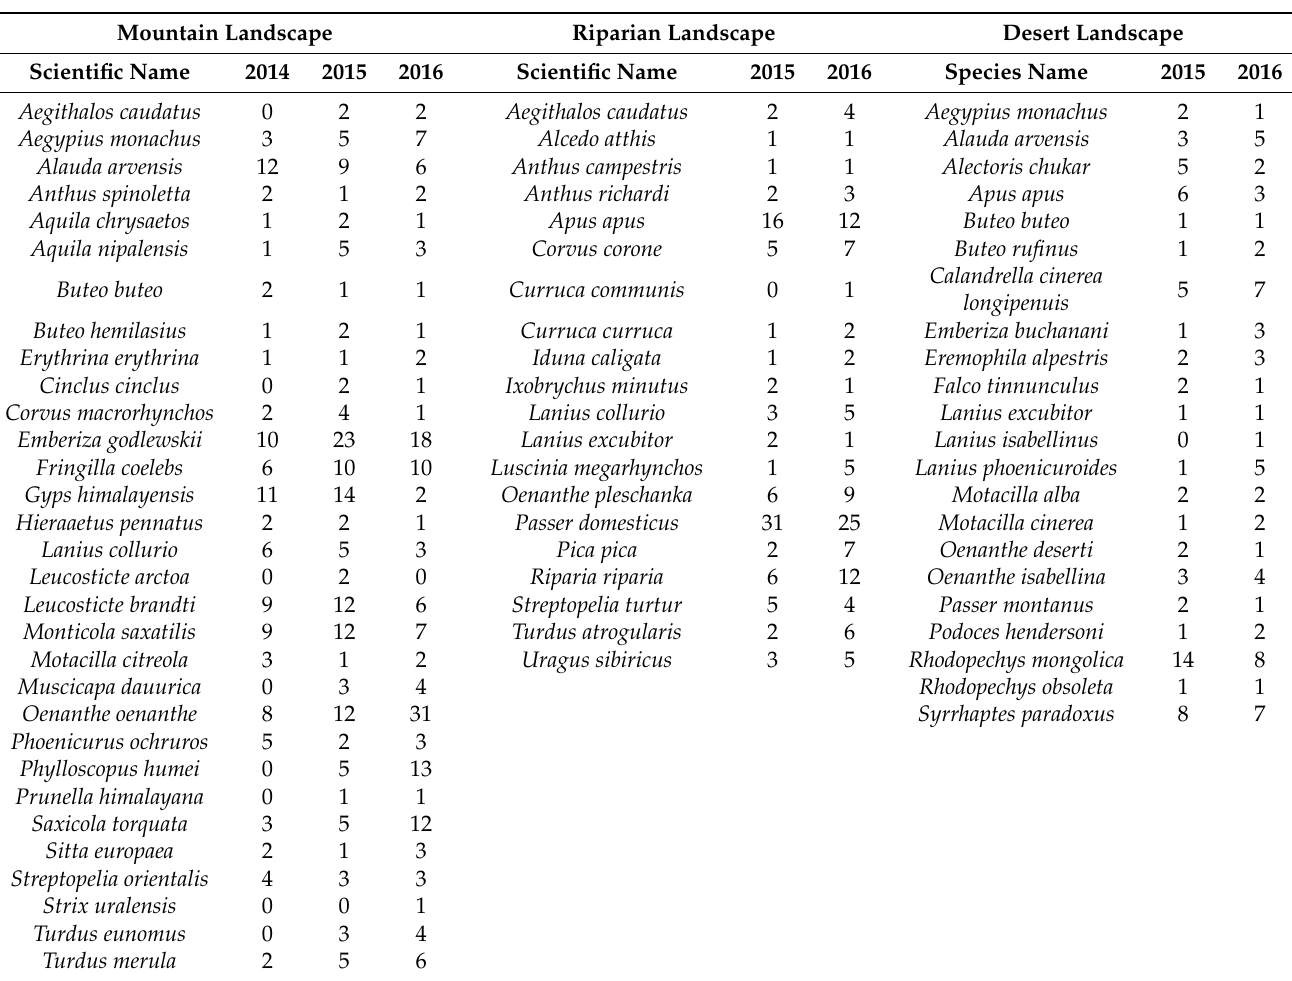
Table A3. The birds detected in different years in one transect in a mountain landscape, riparian landscape and desert landscape, respectively. The bird detection in the riparian landscape and desert landscape were conducted at a walking speed of 2 km/h in both 2015 and 2016. In the mountain landscape, the walking speed was 1~1.5 km/h in 2014 and 2015, and was 2 km/h in 2016. The bird compositions were consistent between 2015 and